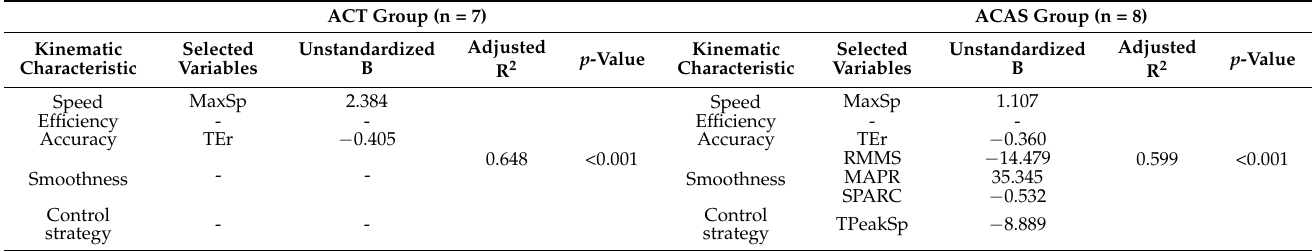
Table 6. Multivariable linear regression analysis of kinematic features for FMA-UE in the ACT and ACAS groups.